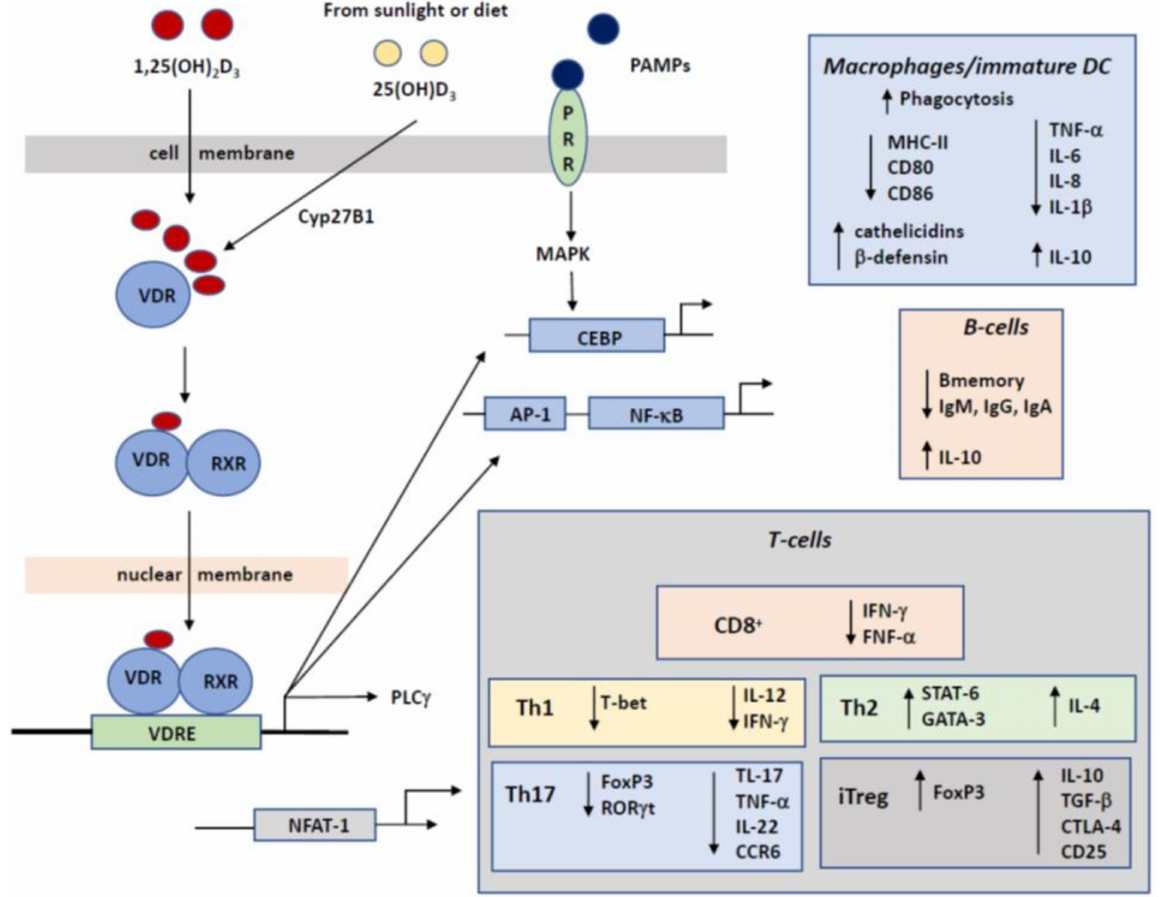
Figure 2. Schematic view of the signaling transduction cascades upon vitamin D interaction with immune cell and their consequences for gene transcription profiles for the different important immune cell